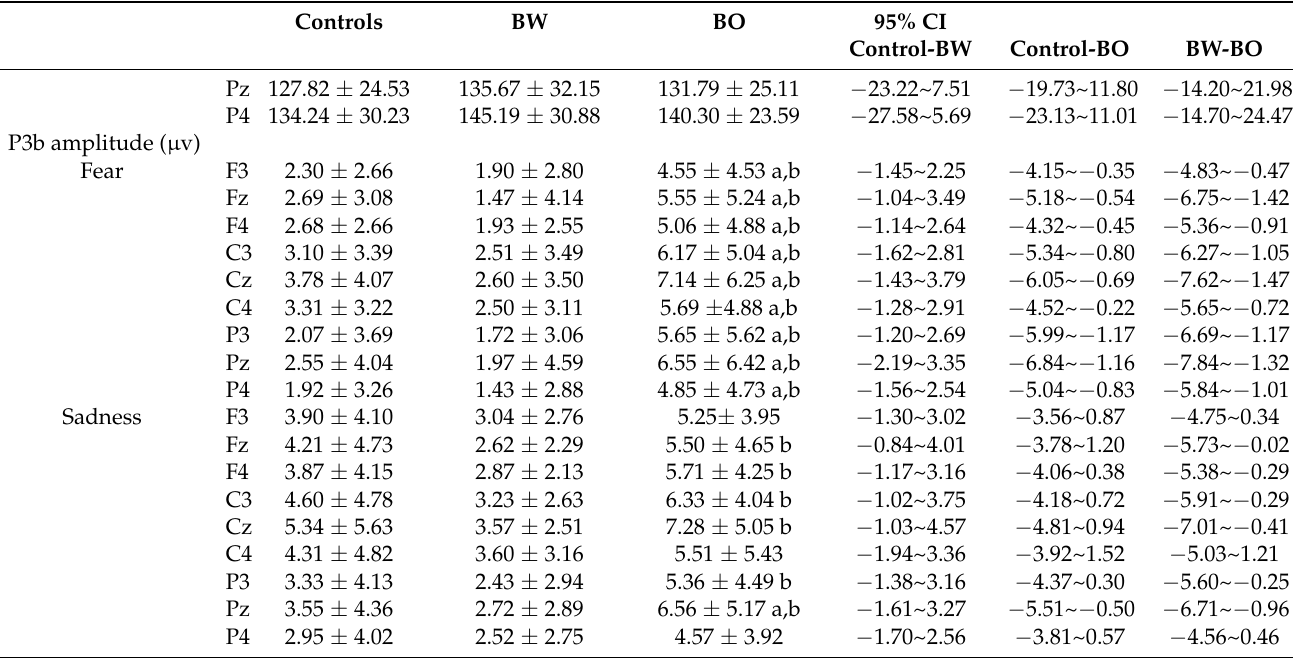
Figure 3. N1 latencies under Erotica and Happiness (left graph), and P3b amplitudes under Fear and Sadness (right graph) at Cz in healthy volunteers (Controls, n = 54), bipolar I disorder patients with (BW, n = 27) and without (BO, n = 26) hypersexuality. Notes: a, p < 0.05 versus controls; b, p < 0.05 versus BW. 3.3. Source Reconstructions After significant differences on N1 latencies and P3b amplitudes under different ex- ternal emotions were found, we located the possible neural sources for these components by performing 3D source reconstruction in 70–200 ms and 400–580 ms time-windows in three groups, respectively. In controls, the bilateral supramarginal gyri under Erotica and